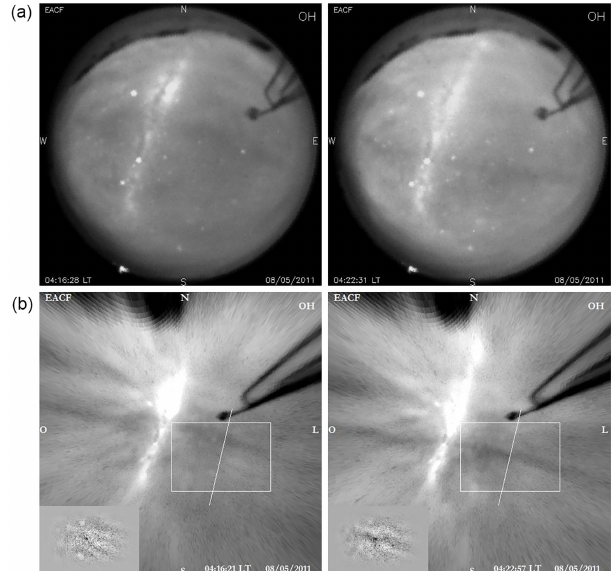
Figure 2. Same as Fig. 1 but for the mesospheric front characterized from 03:11 to 03:16UT on 23